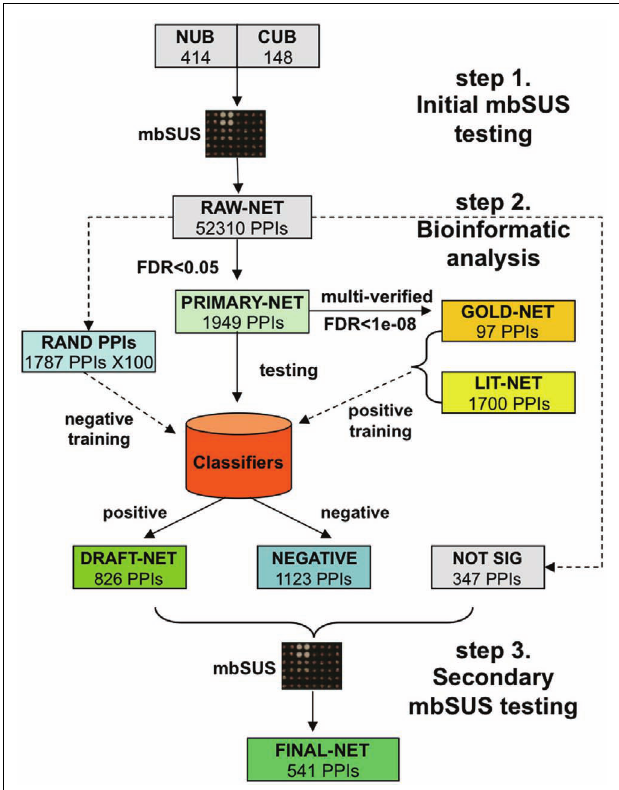
FIGURE 1 | Overall framework of our protein interaction assay system, which has three steps. (1) First mbSUS testing; (2) Bioinformatics to effectively remove false positive interactions; (3) Second mbSUS testing. PRIMARY-NET = statistically positive (FDR < 0.05) interactions from step 1, GOLD-NET = high-confidence interactions from step 1, LIT-NET = literature-curated interactions, RAND PPIs = randomly selected interactions from non-significant interactions in step 1, DRAFT-NET = classified as positive from step 2, NEGATIVE = classified as negative from step 2, NOT-SIG = randomly selected interactions from step 1 that were retested in step 3, FINAL-NET = tested positive in step